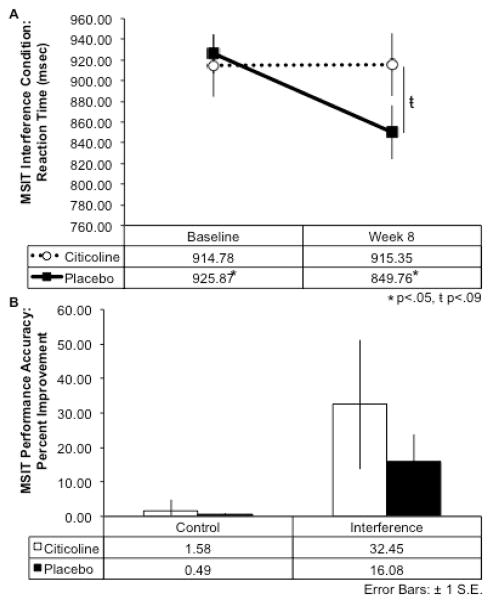
Multi Source Interference Test (MSIT) Percent Improvement of Performance Accuracy and Reaction Time After 8-Week Citicoline TreatmentA.) At baseline, the citicoline and placebo-treated groups exhibited similar reaction time during the interference condition of the MSIT; however, by week 8 the citicoline-treated group exhibited a trend for slower reaction times than the placebo-treated group. Further, the citicoline-treated group generally performed the task more slowly at week 8 than at baseline, while the placebo-treated group performed the task significantly faster over time (t(17) = 2.32, p = .02, 1-tailed). B.) The citicoline-treated group showed greater percent improvement from baseline to week 8 during both the control and interference conditions of the MSIT.